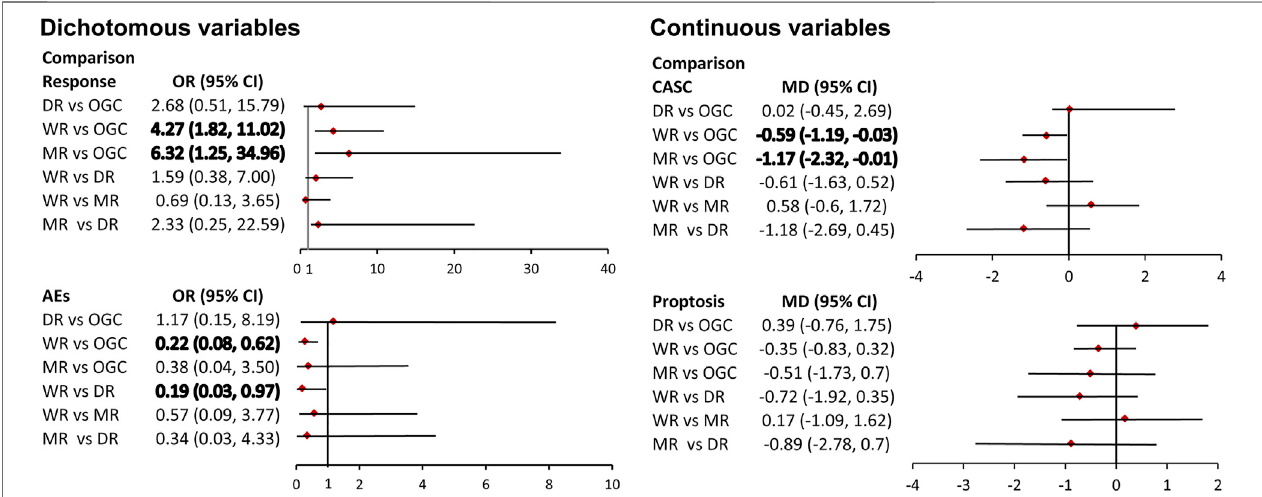
FIGURE 4 | Pooled results of network meta-analysis. The bold number indicates a signi fi cant difference.